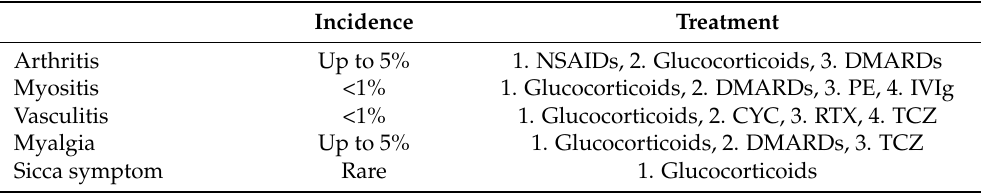
Table 1. Brief summary of rheumatic immune-related adverse events